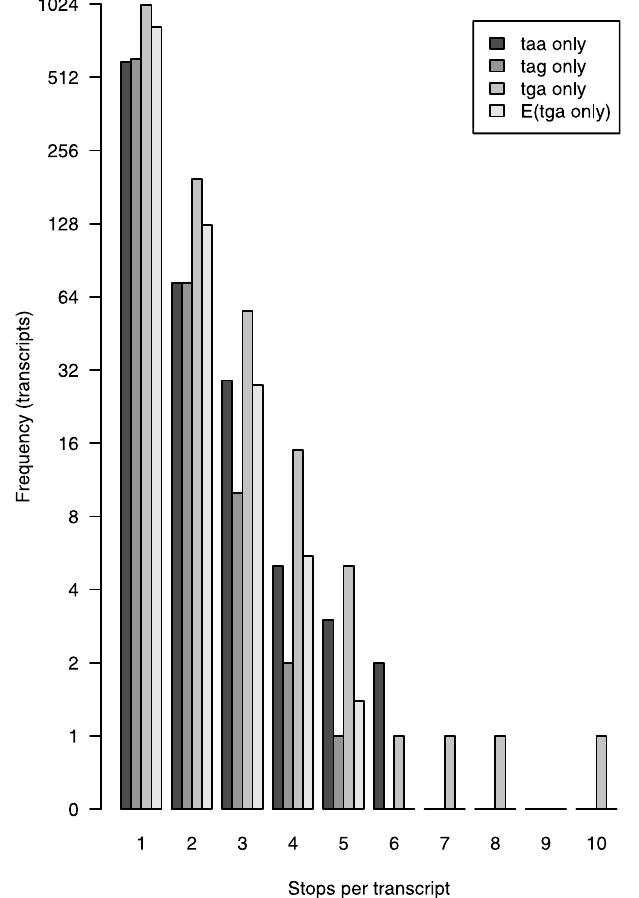
Figure 3. An Excess Number of w mRNAs Have TGA Stop Codons as the Only Reading Frame Disruption DOI: 10.1371/journal.pgen.0020023.g003